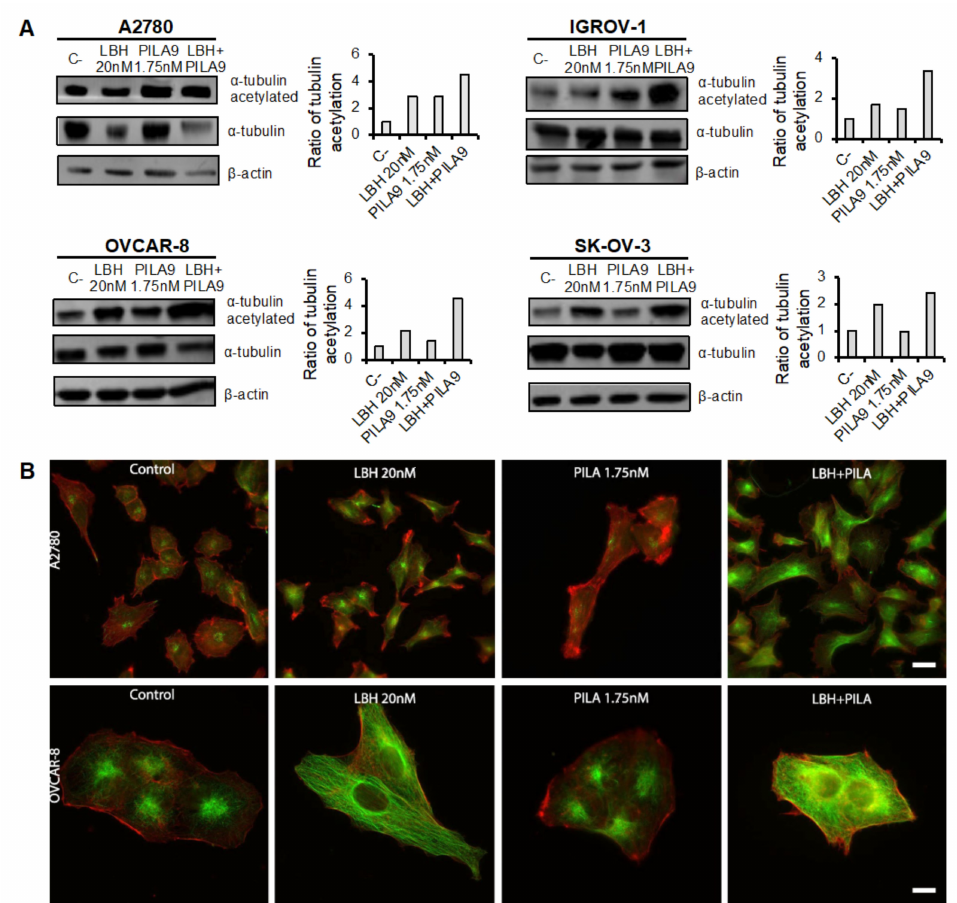
Figure 8. The combination of LBH and PILA9 induces strong acetylation of α -tubulin. ( A ) OCCLs were treated or not with LBH (20 nM) and/or PILA9 (1.75 nM) for 24 h and the acetylation of α -tubulin was observed by western blot. β -actin was used as a loading control. Protein levels were quantified using ImageJ Graphs representing the normalized ratios of acetylated α -tubulin over total α -tubulin, using β -actin levels to normalize. Untreated cells (C-) levels were taken as 100. ( B ) A2780 and OVCAR-8 cells were treated or not with LBH and/or PILA9 and α -tubulin acetylated (green) and actin (red) were observed by immunofluorescence. Scale bar: 10 µ